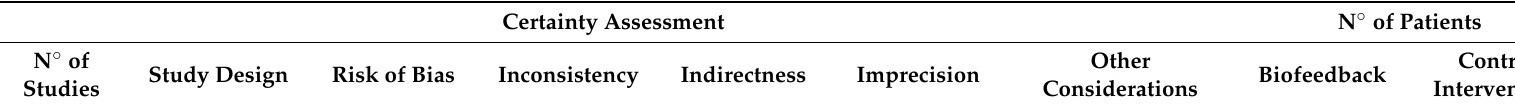
Control Biofeedback Considerations